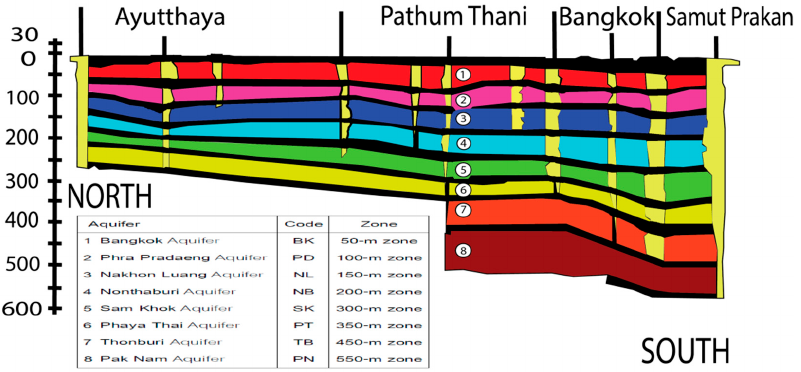
Figure 2 . The groundwater and aquifer levels in the study area. Figure 2. The groundwater and aquifer levels in the study area.